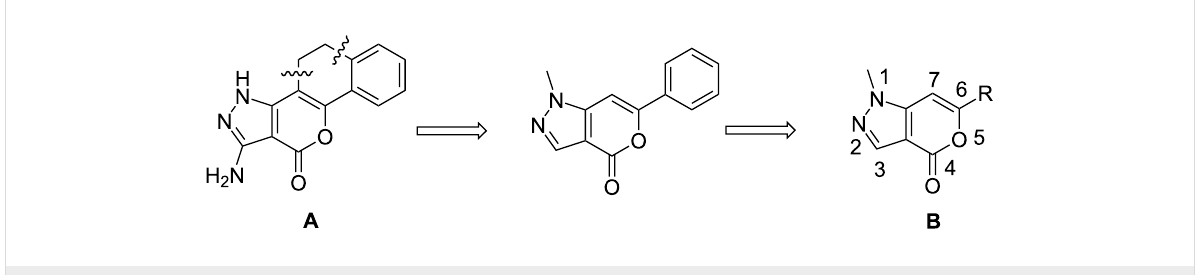
Figure 1: Polycyclic azaheteroaromatics ( A ) and pyrano[4,3- c ]pyrazol-4(1 H )-ones ( B ).